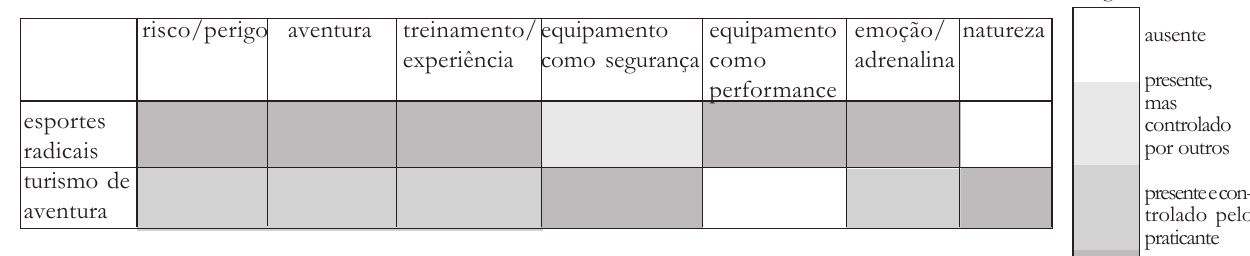
Figura 1. Contrastando turismo de aventura e esportes radicais de acordo com as dimensões do risco-